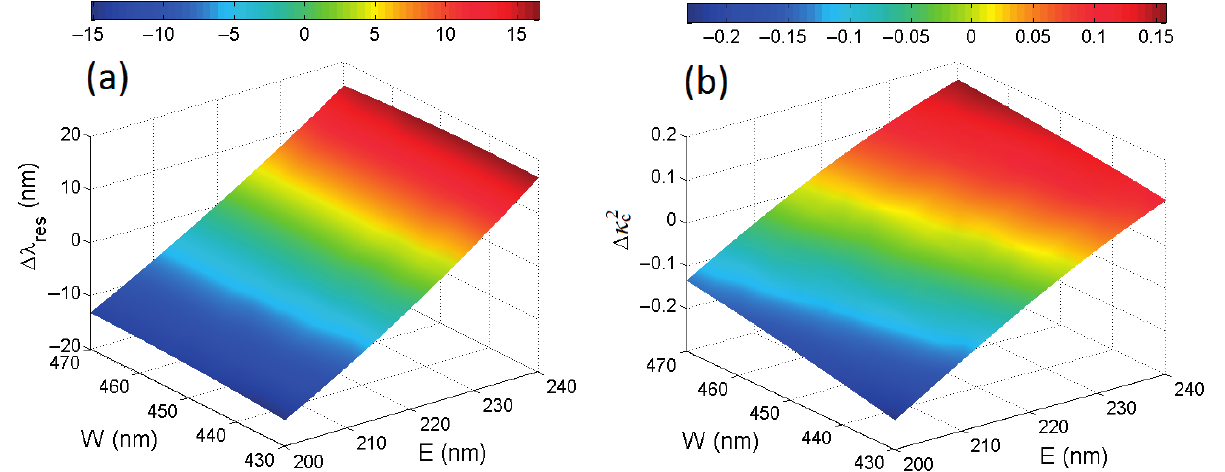
Figure 7. ( a ) Resonant wavelength and ( b ) power coupling coefficient variations ( Δ λ and Δ κ (cid:3030)(cid:2870) , respectively) as a function of SOI rib waveguide fabrication tolerances at the operating wavelength of λ = 1.55 μ